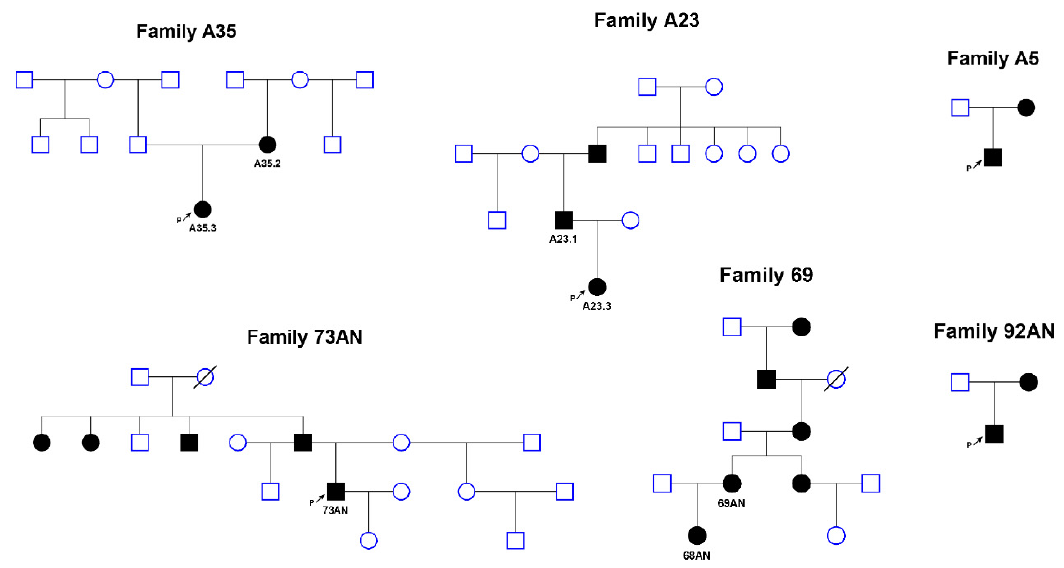
Figure 1. Pedigrees of familial cases of aniridia caused by deletions of the 11p13